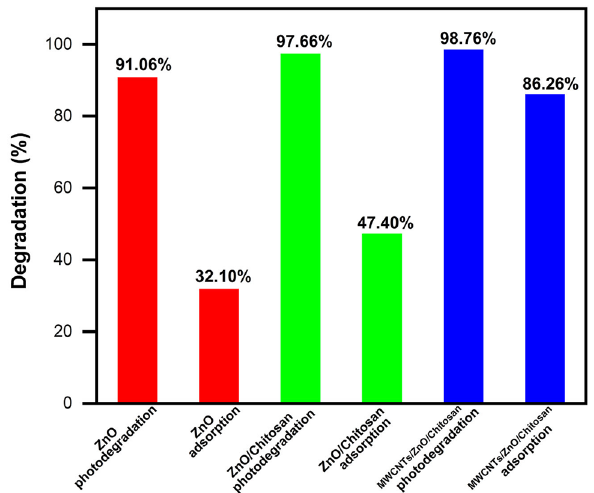
Figure 12. Comparison of MB dye degradation in UV–Vis and adsorption by ZnO, ZnO/Chitosan and